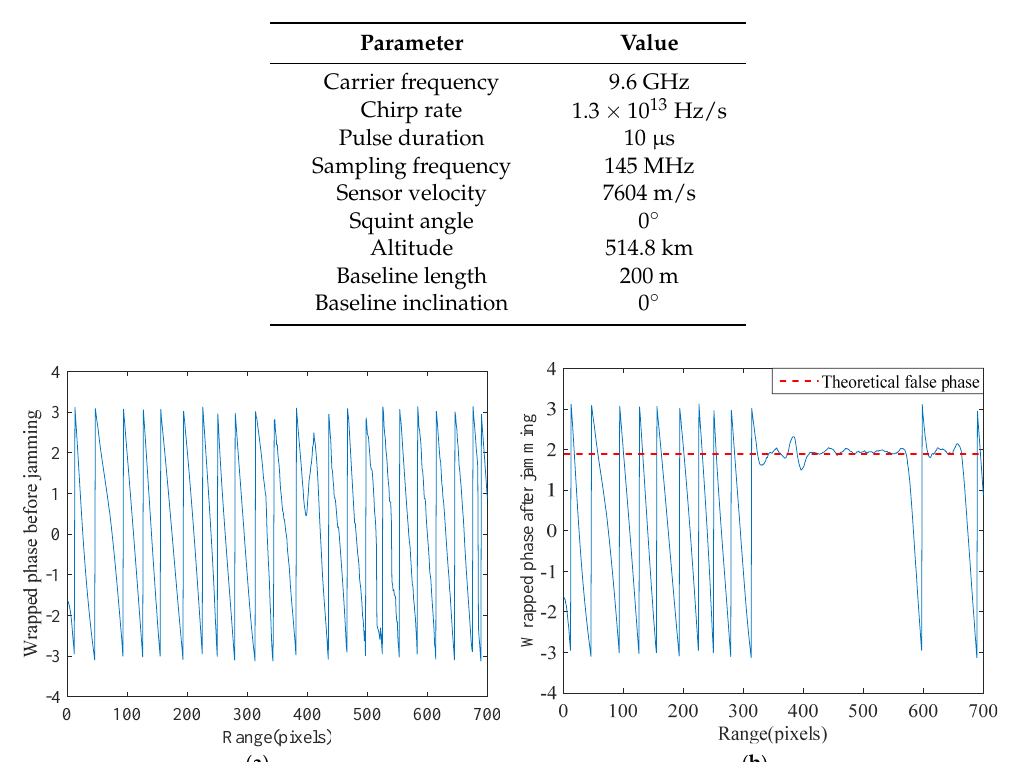
Figure 2. Comparison between the interferometric phase before and after SAR deceptive jamming: ( a ) interferometric phase before jamming; and ( b ) interferometric phase after jamming.